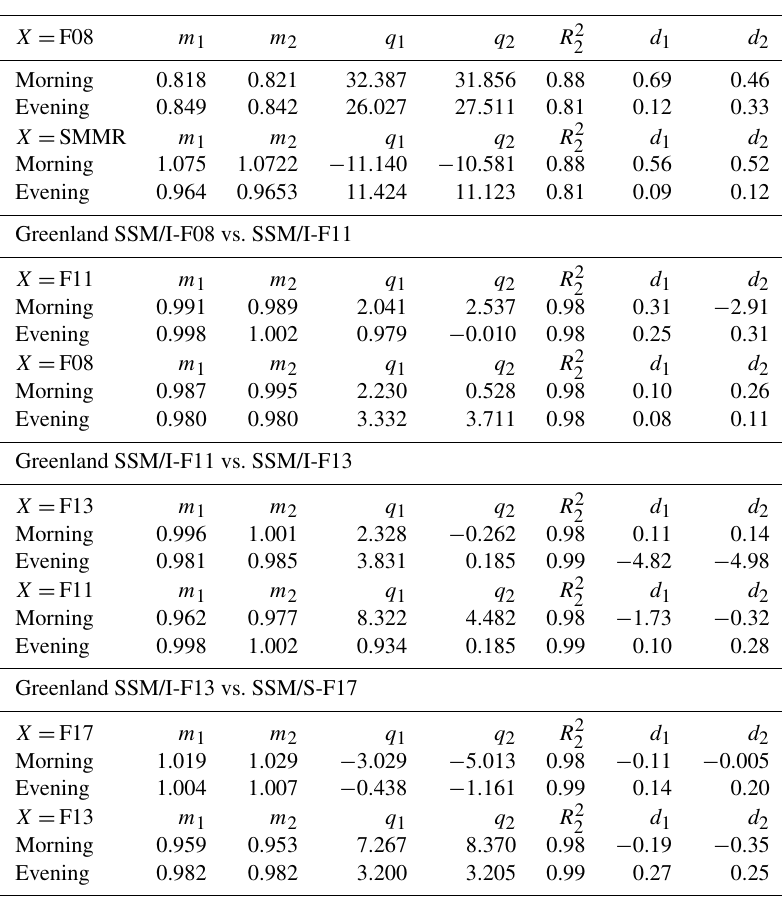
Table 4. Slope ( m ) and intercept ( q ) obtained from the linear regression analysis between the selected satellite pairs’ enhanced PMW T b at 37GHz, horizontal polarization, over Greenland. The subscripts refer to the case where the coefficients are weighted by means of the R 2 (case 1, see Eqs. 5 and 6) or cases where they are not weighted by means of the R 2 (case 2). We also report the values for the R 2 and the d values computed according to Eq.